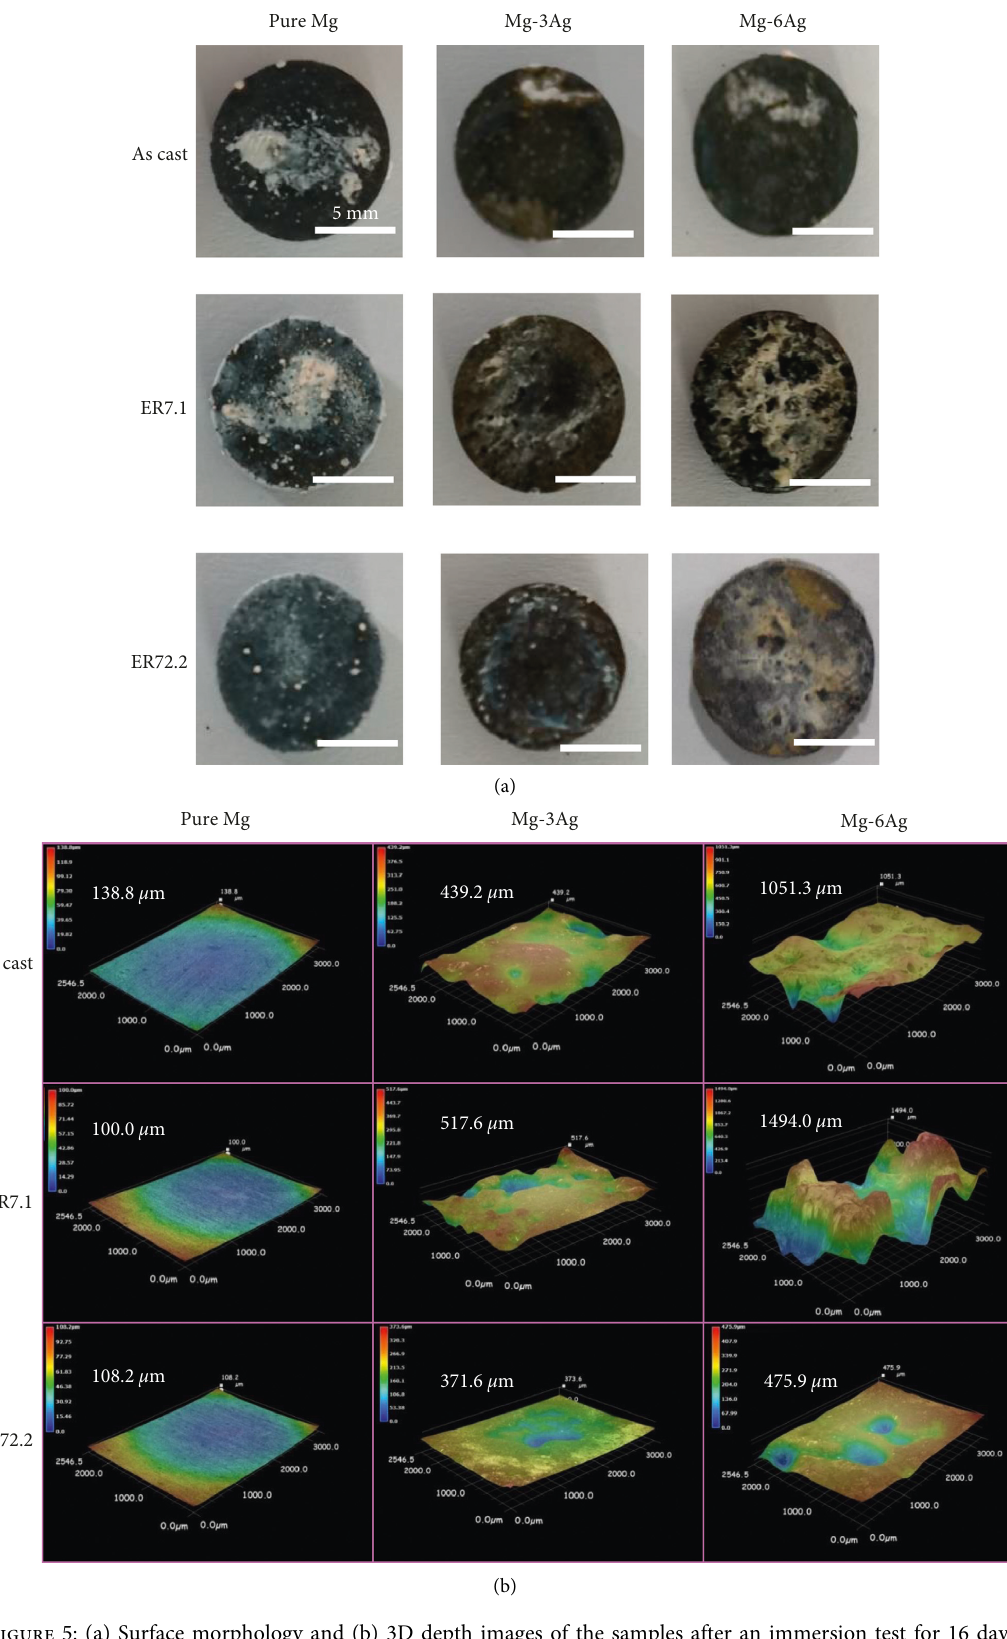
Figure 5: (a) Surface morphology and (b) 3D depth images of the samples after an immersion test for 16